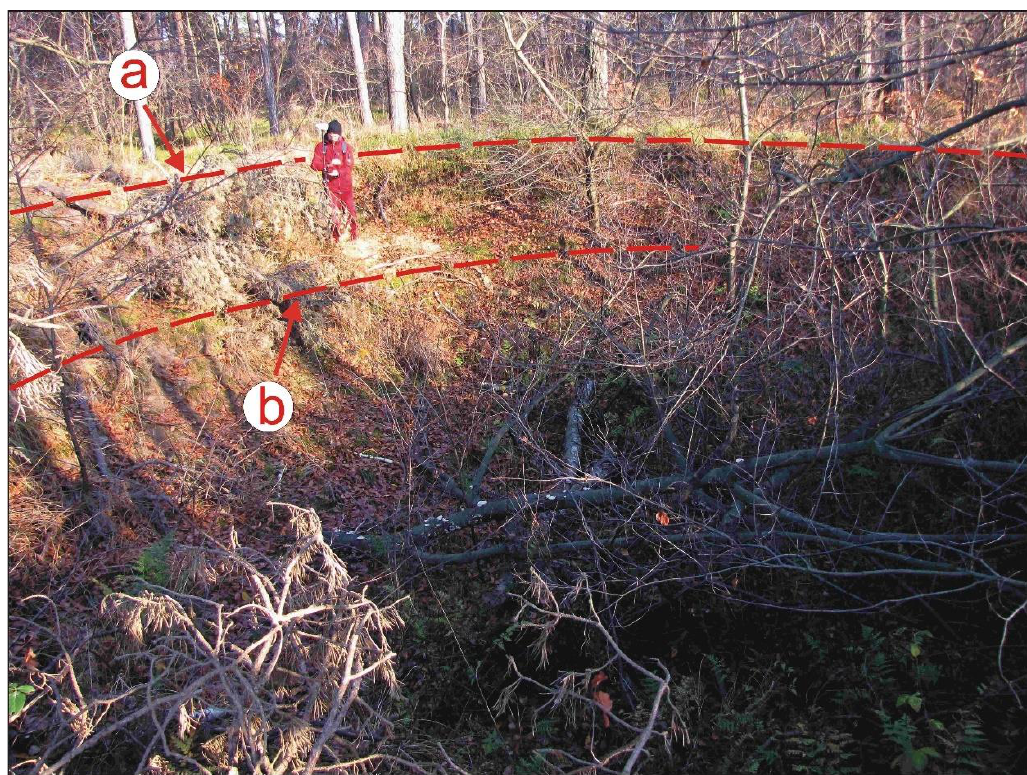
Figure 9. A large crater created by concentric explosions of two bombs during World War II: (a) crater edge; (b) edge of the slump formed after the second explosion (photo: J.M. Waga). This slump may have resulted from the edge of the older crater sliding after the second explosion. In waterlogged areas, this takes the form of arcs and rings on the bottoms of flooded craters [59].